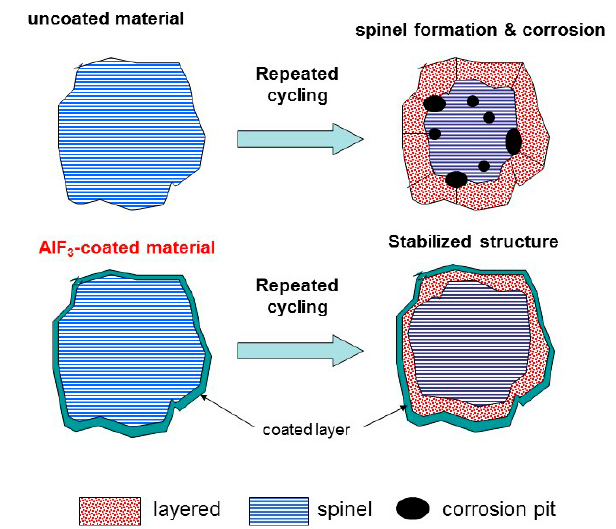
Figure 15. Scheme of transformation of active particle of Li-rich layered oxide upon repeated cycling. Reproduced with permission from [97]. Copyright 2014, American Chemical Society.